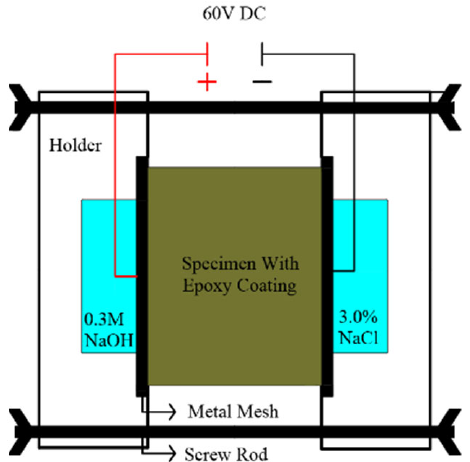
Figure 4. Schematic of the RCP test.